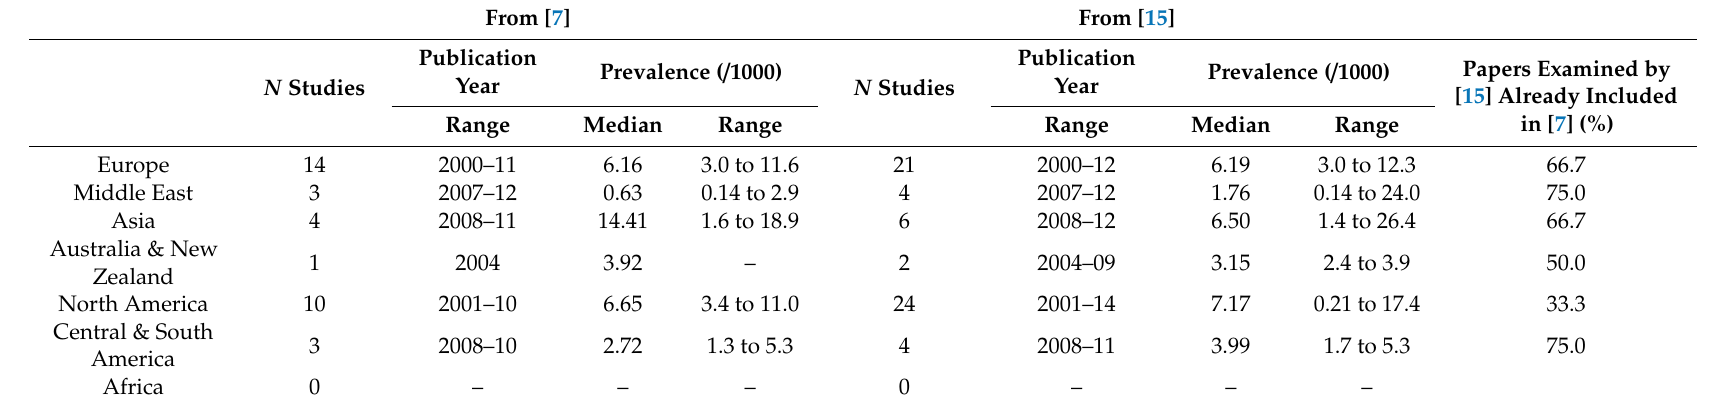
Table 1. Summary of PDD prevalence estimates of the studies included in the reviews by [7,15]